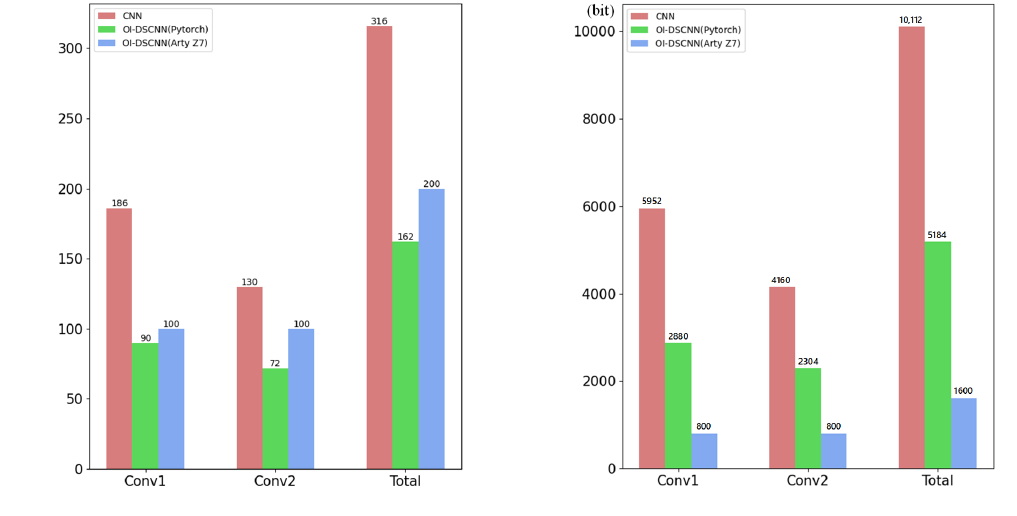
( b ) Compare the memory consumption of the convo- lutional layer parameters. Figure 6. Convolutional layer parameters for CNN, OI-DSCNN in Pytorch, and OI-DSCNN in Arty Z7. Table 5. The CNN model